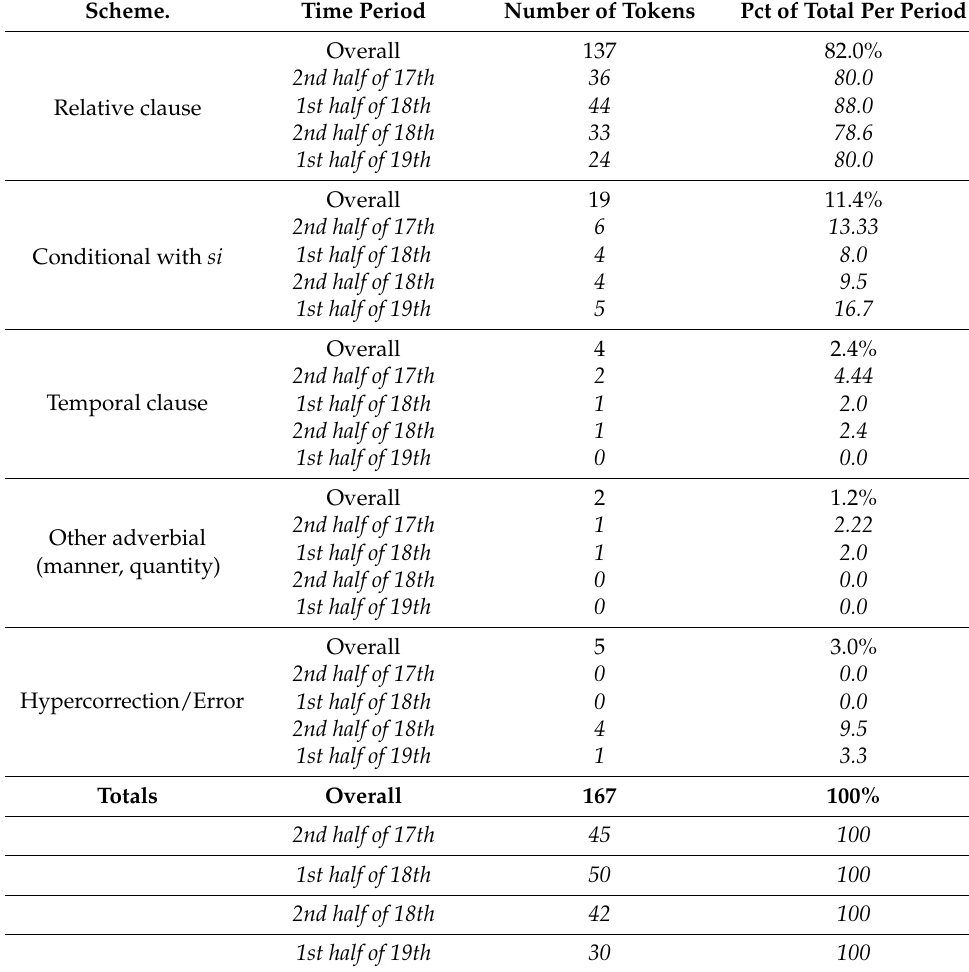
Table 2. Future subjunctive in Corpus 2 by structure and time period.